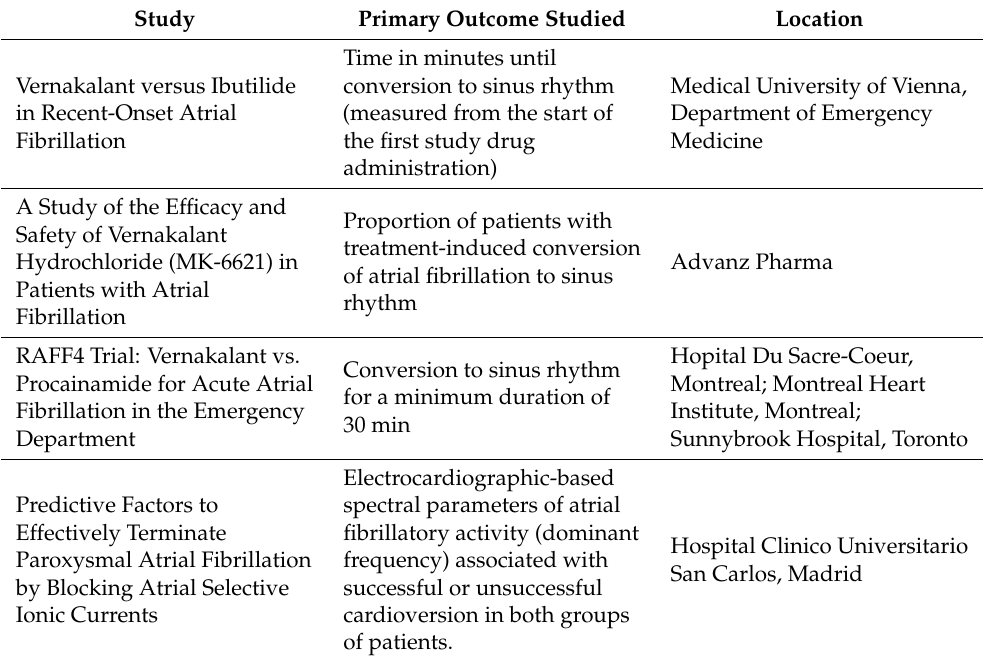
Table 3. Current and previous studies of vernakalant (according to the clinicaltrials.gov